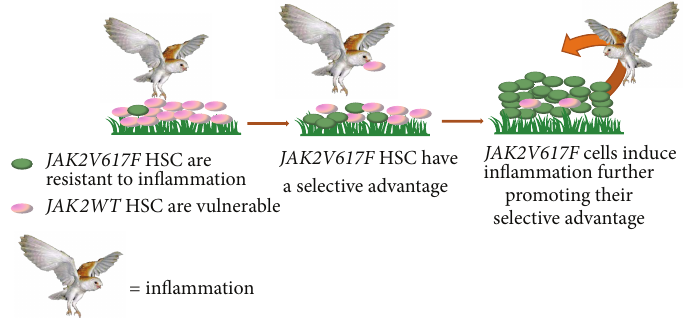
Figure 2: Model of inflammation as a driver of expansion of the JAK2V617F clone in MPN. JAK2V617F -mutated hematopoietic stem cells (HSC) are resistant to inflammation giving them a selective advantage in environments with high